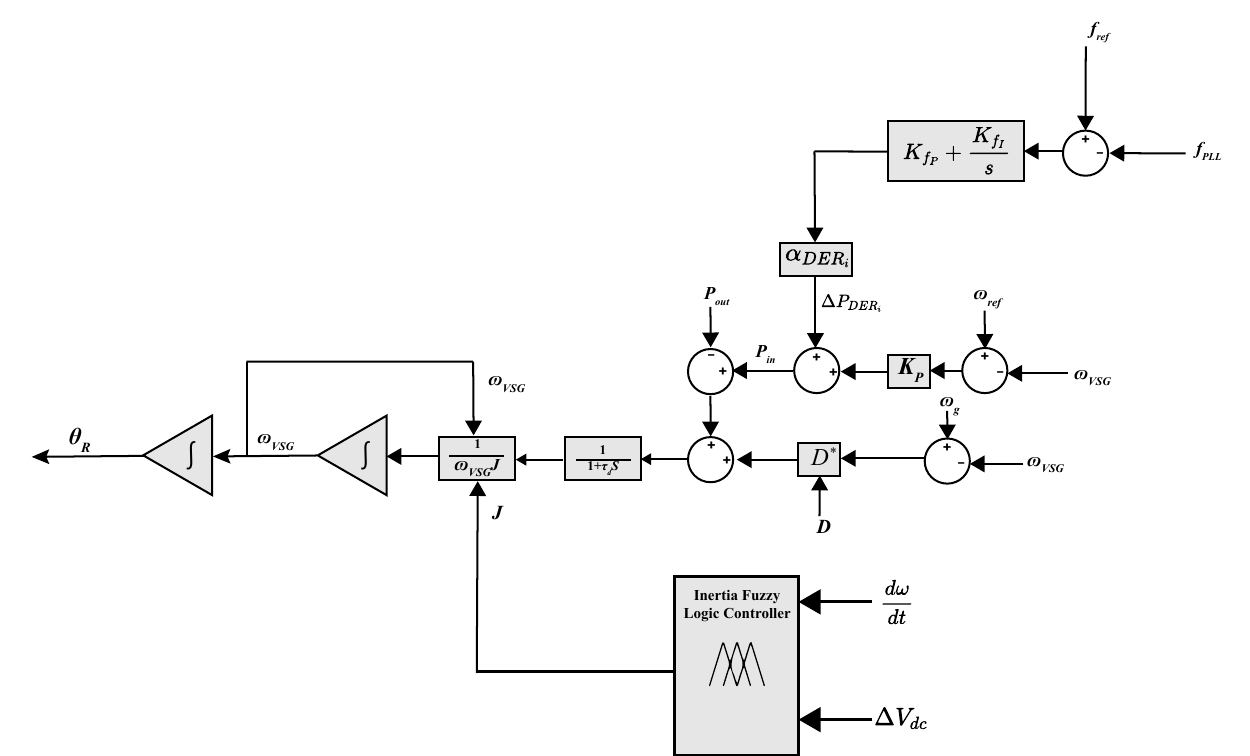
Figure 7. Proposed decentralized fuzzy-logic-based adaptive